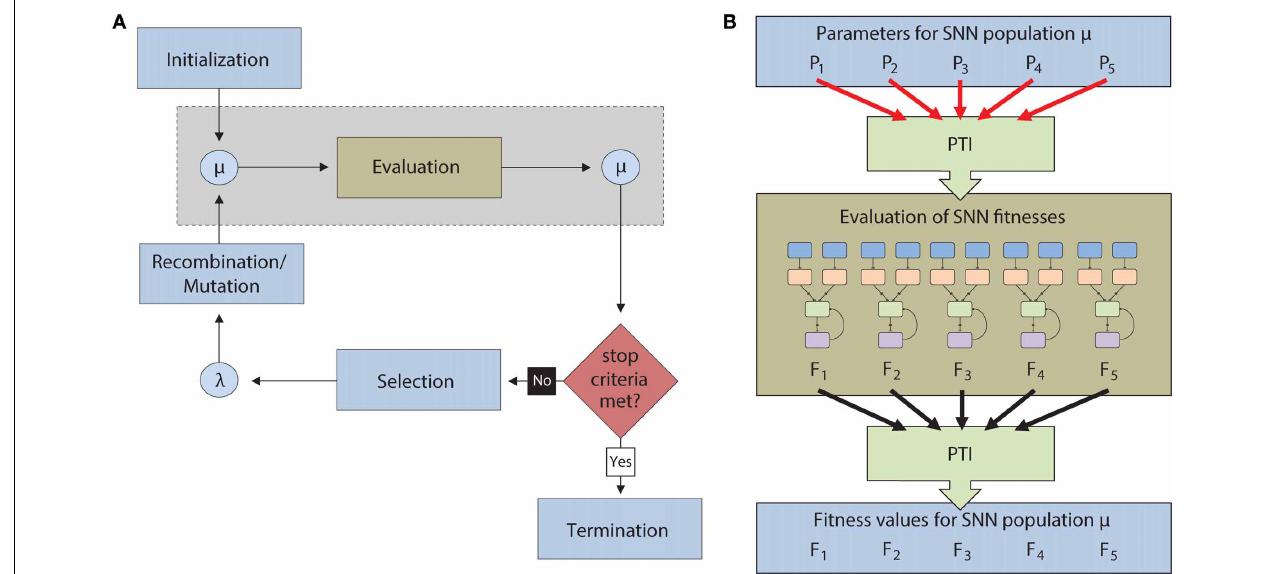
FIGURE 2 | (A) Flow chart for the execution of an Evolutionary Algorithm (EA). A population of individuals ( μ ) is first initialized and then evaluated. After evaluation, the most successful individuals are selected to reproduce via recombination and mutation to create an offspring generation ( λ ). The offspring then become parents for a new generation of the EA. This continues until a termination condition is reached. The light blue boxes denote operations that are carried out serially on the CPU while the light brown box denotes operations